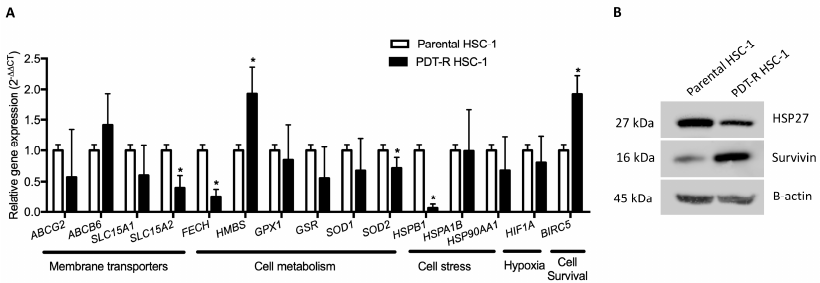
Figure 4. ( A ) Transcriptional expression of genes associated with membrane transporters, cell metabolism (enzymes), cell stress, hypoxia and cell survival in HSC-1-parental and resistant cells. ( B ) Protein expression of HSP27 and survivin in parental and PDT-R HSC-1. Values of p < 0.05 were considered statistically significant. * p < 0.05. Data were expressed as mean ± SD of three biological replicates. biological